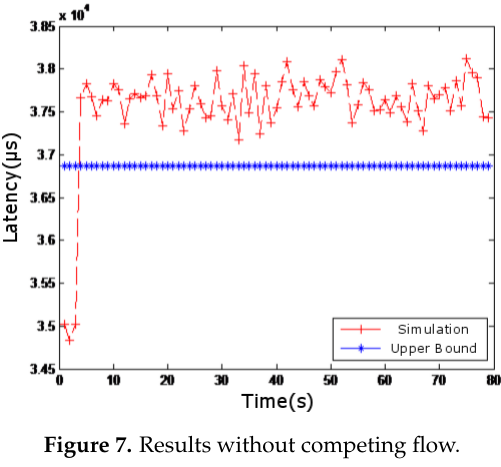
Figure 7. Results without competing flow.